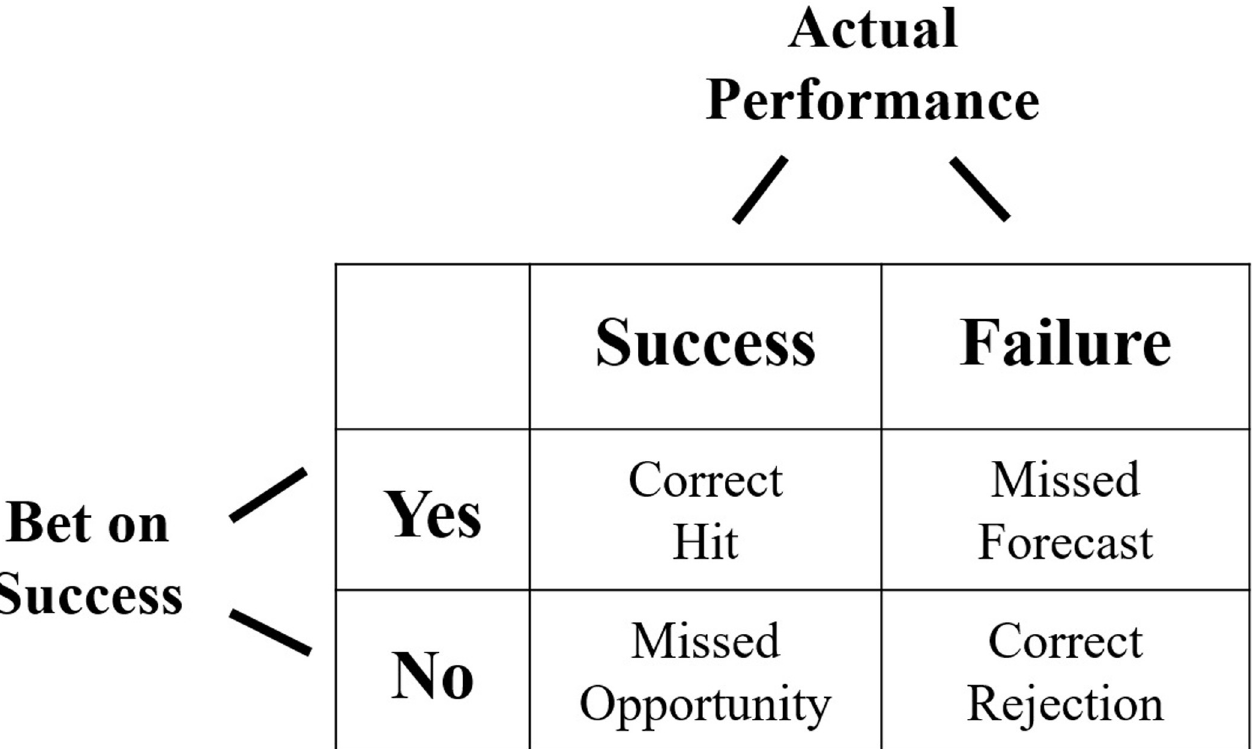
Fig 1. Possible scenarios in the betting task. Positive illusions = Total missed forecasts / (Total missed forecasts + Total correct hits). Negative illusions = Total missed opportunities / (Total missed opportunities + Total correct rejections).